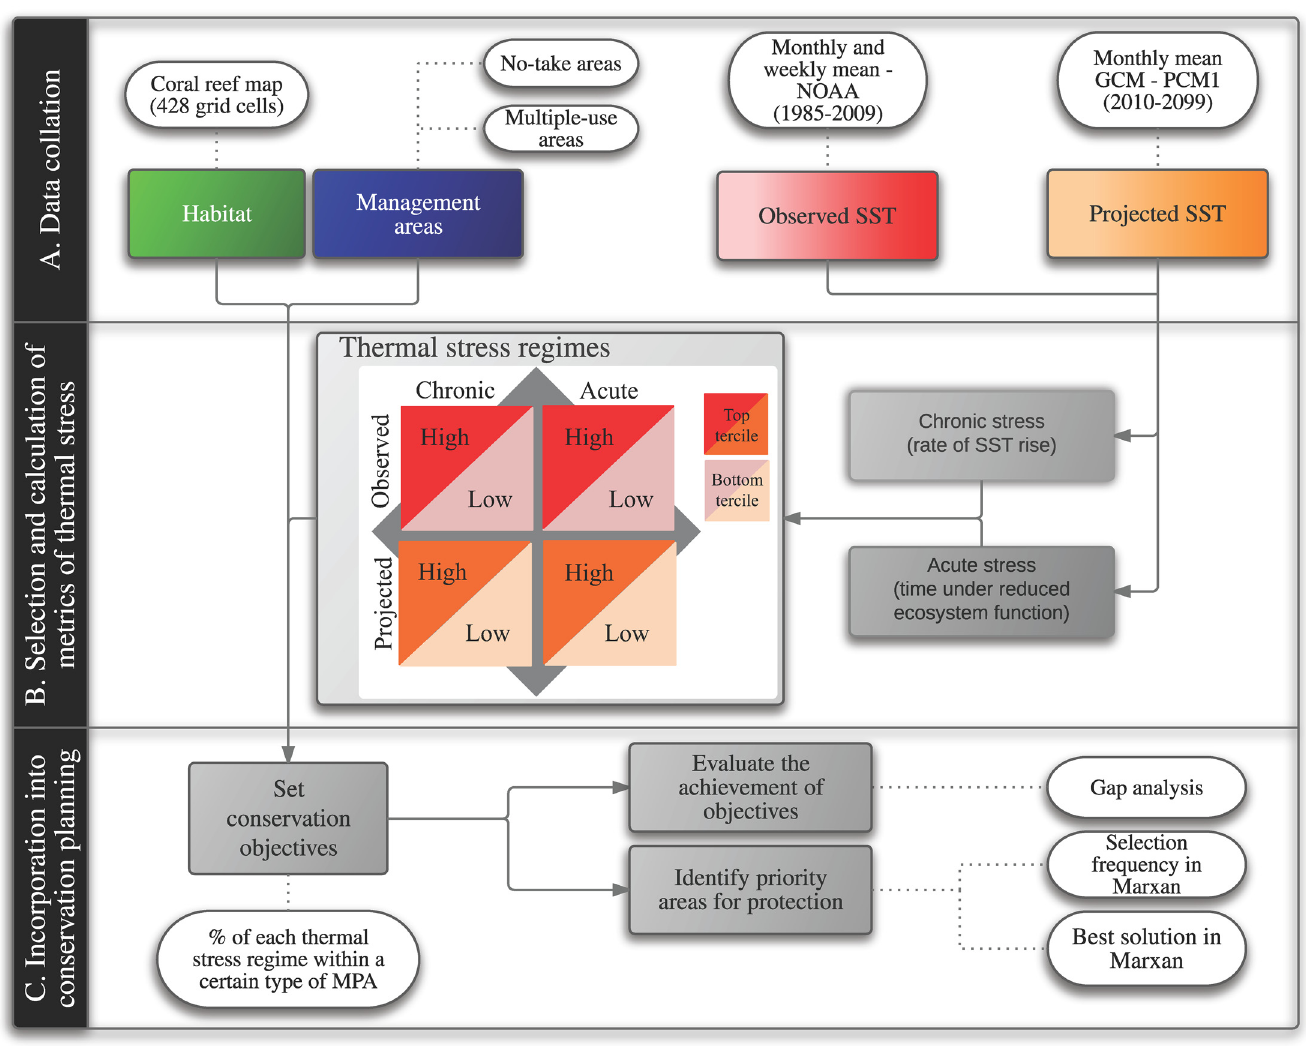
Fig 1. Methods of this paper divided into three major phases. (A) Data collation involved acquisition of habitat data (green box), boundaries of marine protected areas (MPAs) (blue box), and observed and projected data (red and orange boxes, respectively) on sea-surface temperature (SST). In the selection and calculation of metrics of thermal stress (B), we derived metrics of chronic and acute stress from observed and projected datasets and combined them to define thermal-stress regimes. Regimes were delineated based on upper and lower terciles labelled as “ high ” (highest 33% of values, dark red or orange) and “ low ” (lowest 33% of values, light red or orange), respectively. The incorporation of warming disturbances into conservation planning (C) consisted of setting conservation objectives for each thermal-stress regime, evaluating their achievement in existing MPAs, and identifying priority areas that would achieve unmet objectives. Arrows in gray indicate the flow of information and lighter boxes linked by dashed lines depict types of data or analyses involved in each step.